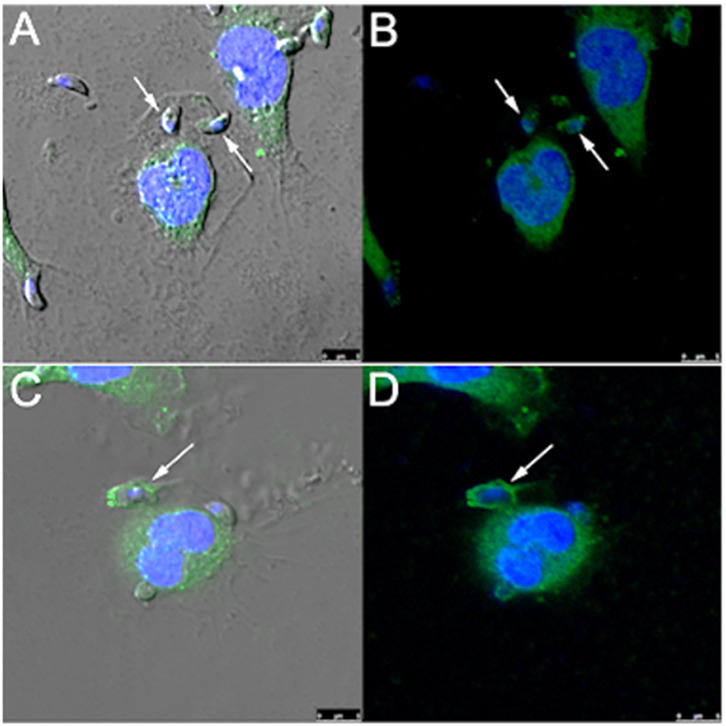
T. gondii co-localizes with rabankyrin 5 and PAK1 into the parasitophorous vacuole in peritoneal macrophages. Tachyzoites were incubated with peritoneal macrophages for 1 h. After that, cells were fixed and processed for observation by confocal laser scanning microscopy. (A,B) DAPI (blue), anti-rabankyrin 5 Alexa 488 (green); (C,D) DAPI (blue), anti Pak1 Alexa 488 (green). Note that tachyzoites (arrow) co-localize with rabankyrin 5 and Pak1.